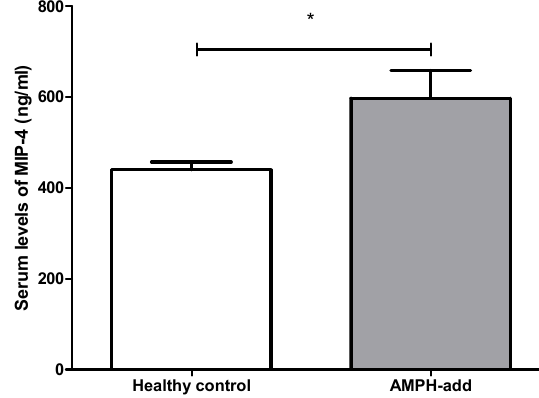
Figure 3. Comparison of MIP-4 serum level between AMPH-add and control. Data are expressed as mean ± standard error. Statistical analysis was carried out using unpaired Student’s t -test. *: statistically significant at p < 0.05.